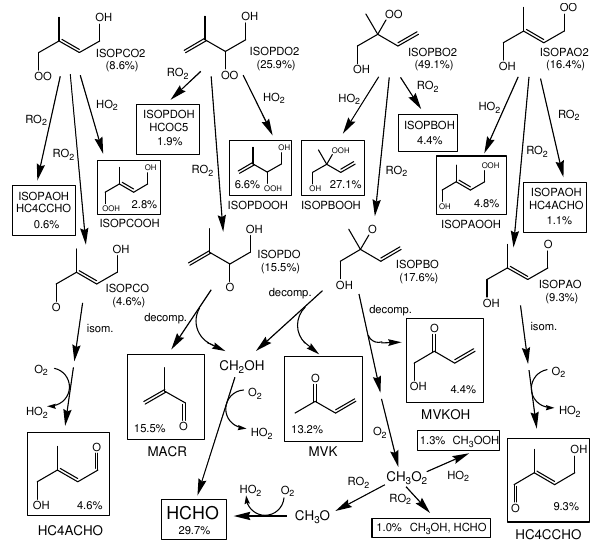
Fig. 2. MCM v3.1 representation of the OH initiated degradation of isoprene to first generation products, in the absence of NO x (routes to formation of initial peroxy radicals are as shown in Fig. 1). Species names correspond to those appearing in MCM v3.1. Closed-shell products are displayed in boxes, along with their molar yields (N.B., HCHO, HC4ACHO and HC4CCHO are generated by more than one displayed reaction, such that their respective total molar yields are 30.7%, 5.8% and 9.9%). The yields correspond to conditions representative of traditional NO x -free chamber experiments with no primary HO 2 source (see text).